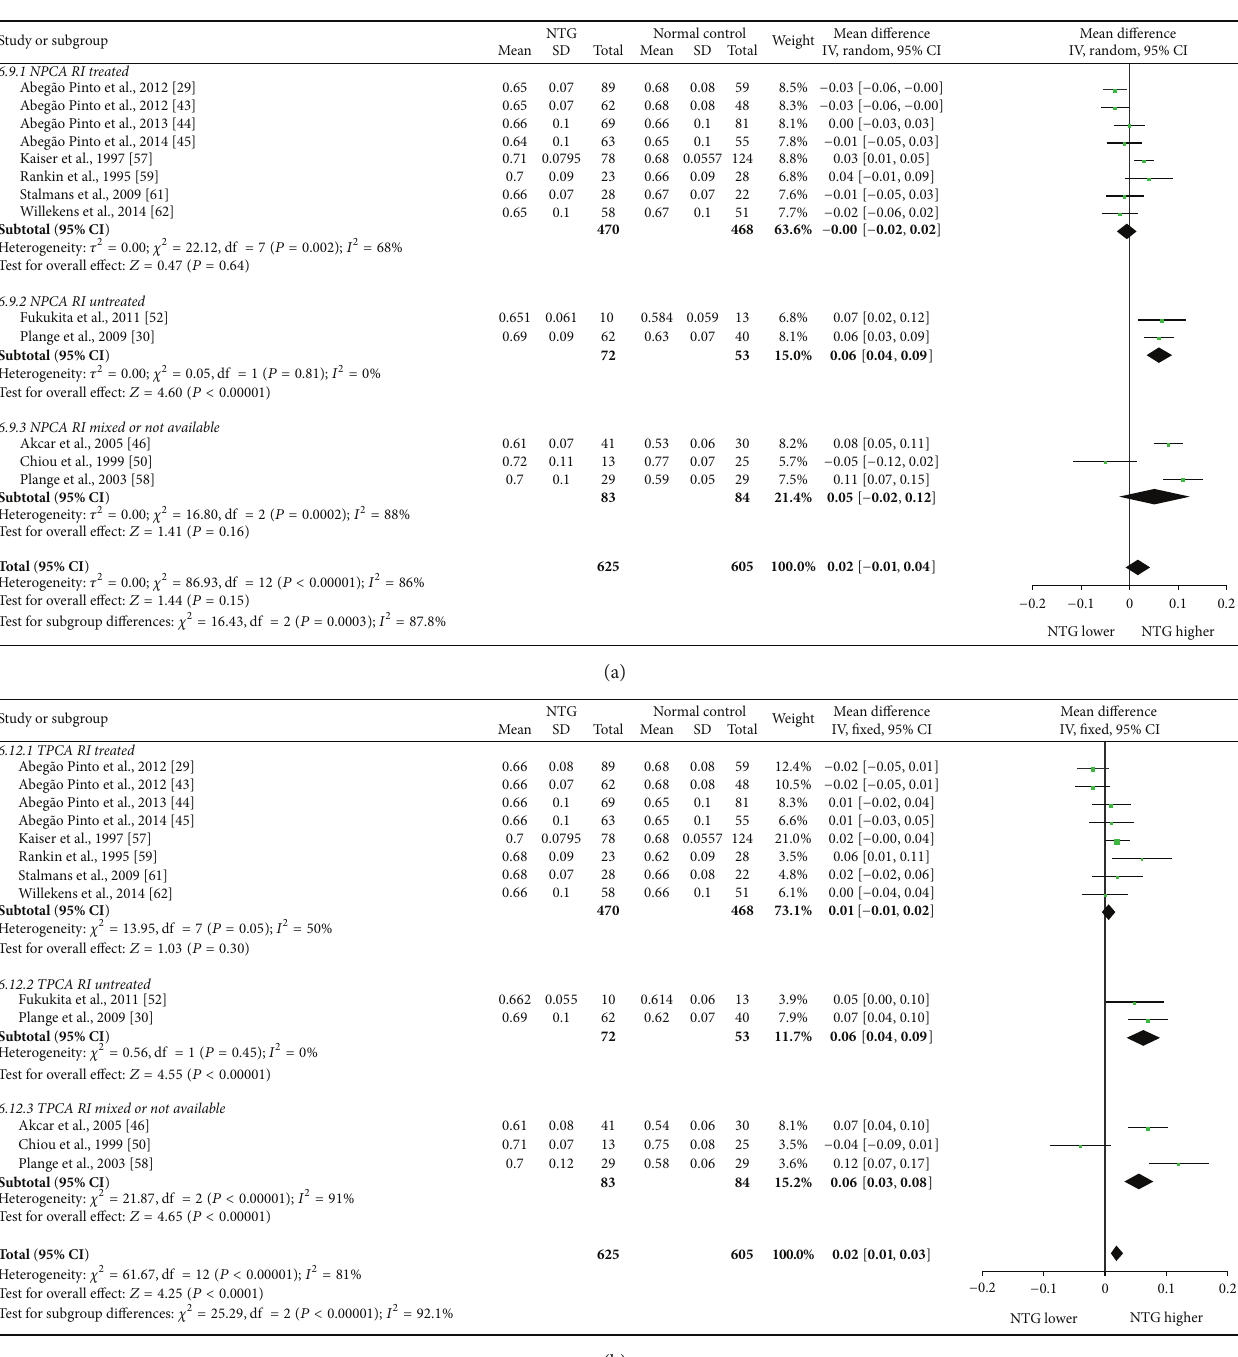
Figure 9: Forest plot of RI in NPCA and